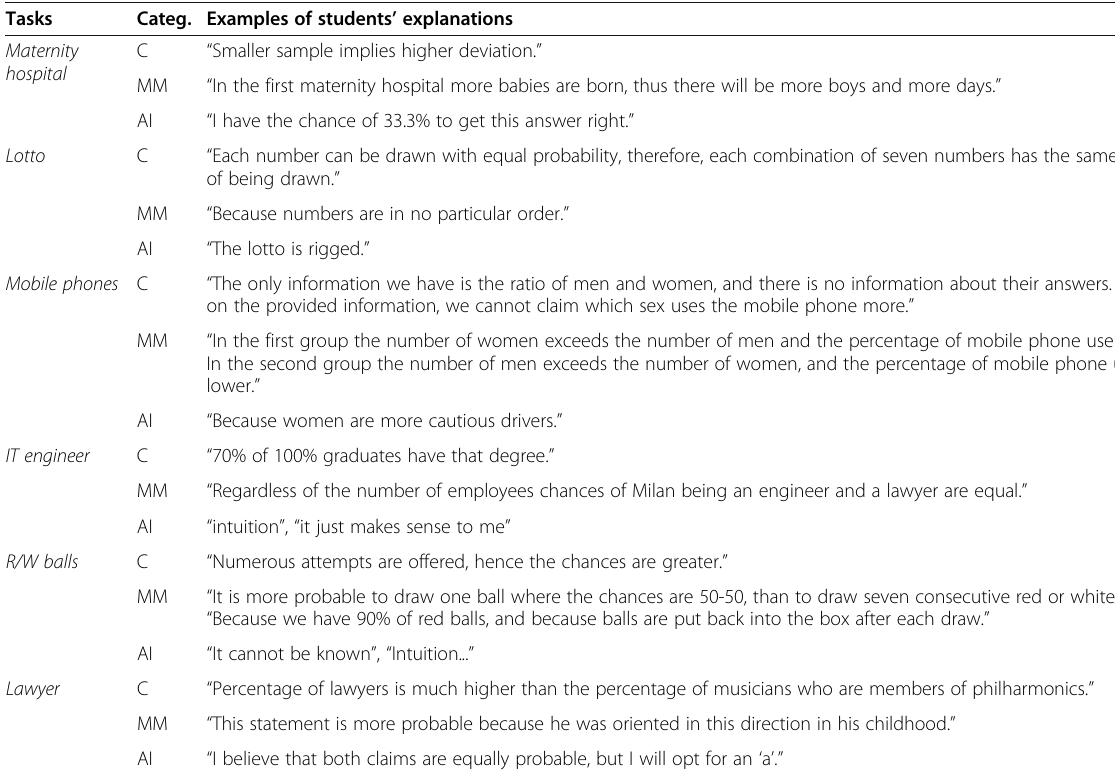
Table 2 Examples of students ’ explanations within the categories, C, MM, AIs Tasks Categ. Examples of students ’